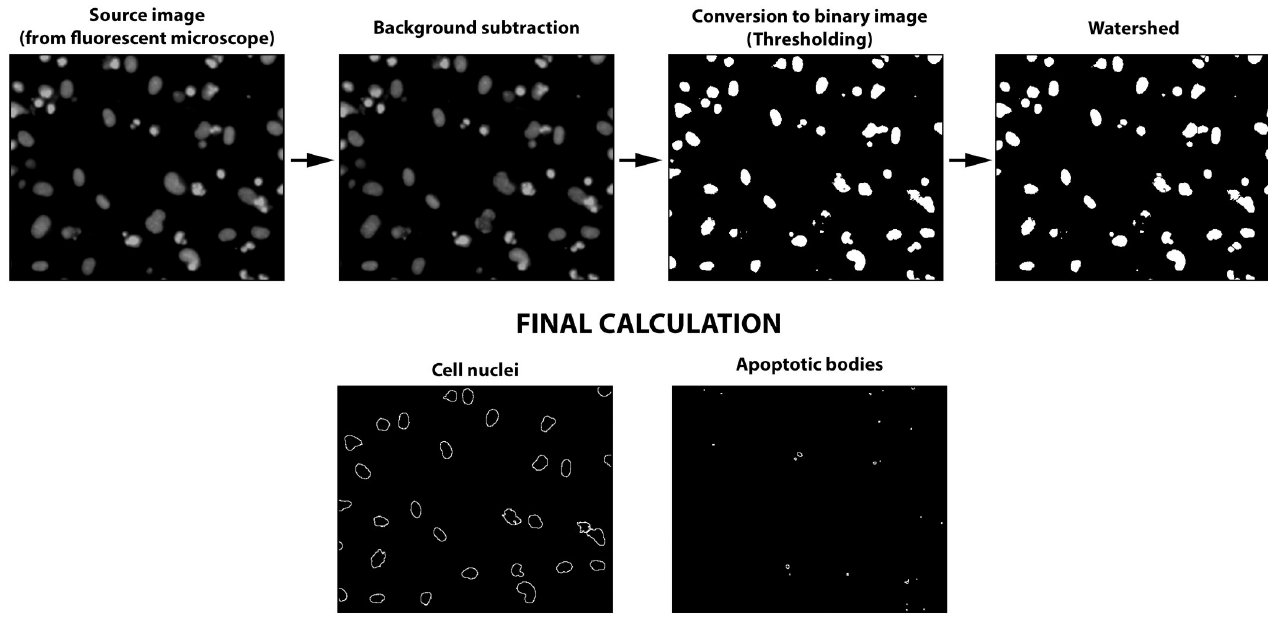
Fig 4. A schematic chart of the quantitative image analysis processed with ImageJ macros.